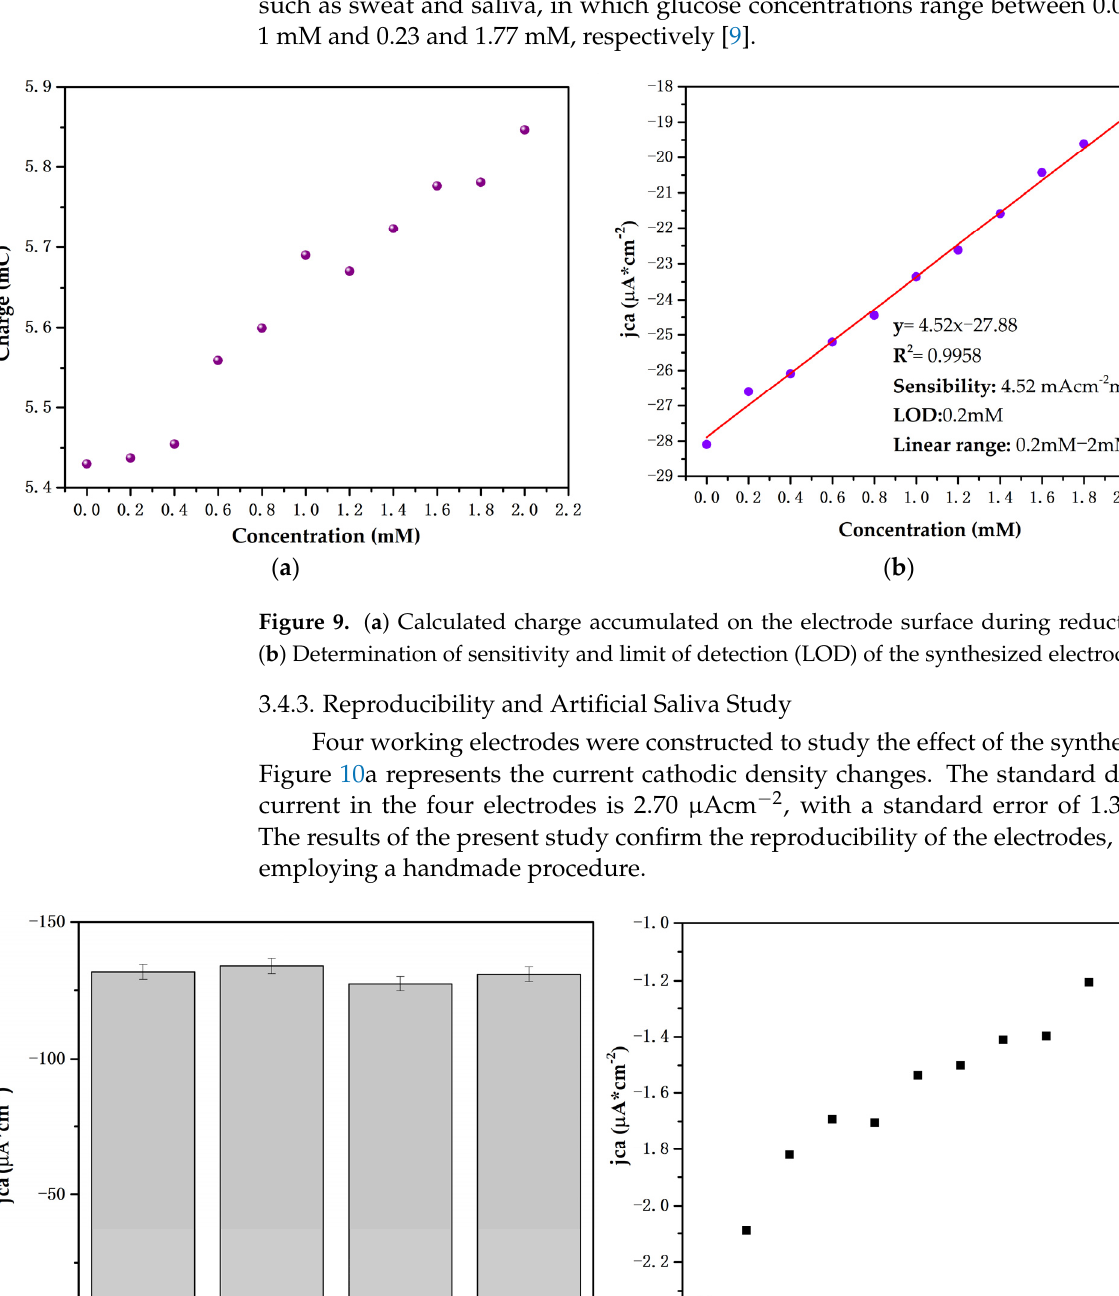
( b ) Figure 8. ( a ) Ti/TiO 2 electrode response to double-pulse chronoamperometry in a pH 7 PBS and glucose from 0 to 2 mM. ( b ) Magnification of the second chronoamperometric pulse region.